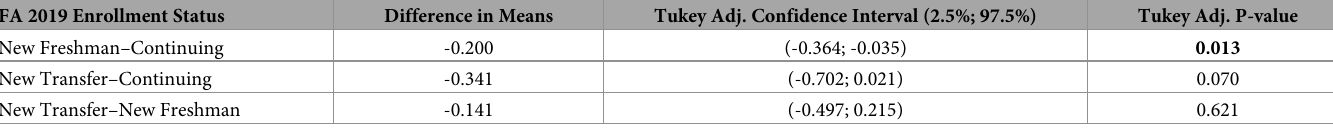
Table 4. ANOVA results for GPA change (before vs. during COVID-19) by enrollment status in FA 2019 [calculus